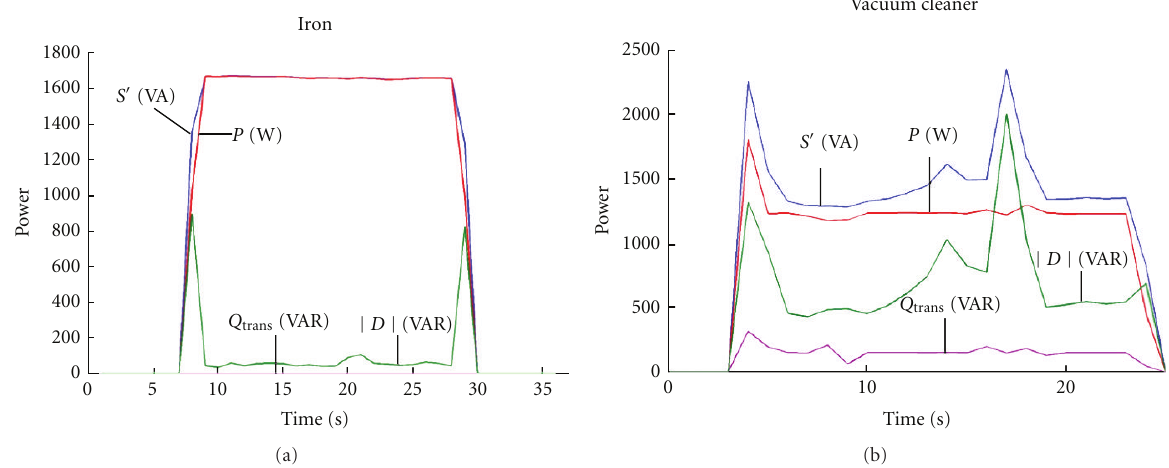
Figure 5: House electricity demand and information extracted: real power P , apparent power S , and reactive power D of an iron (a) and of a washing machine (b)